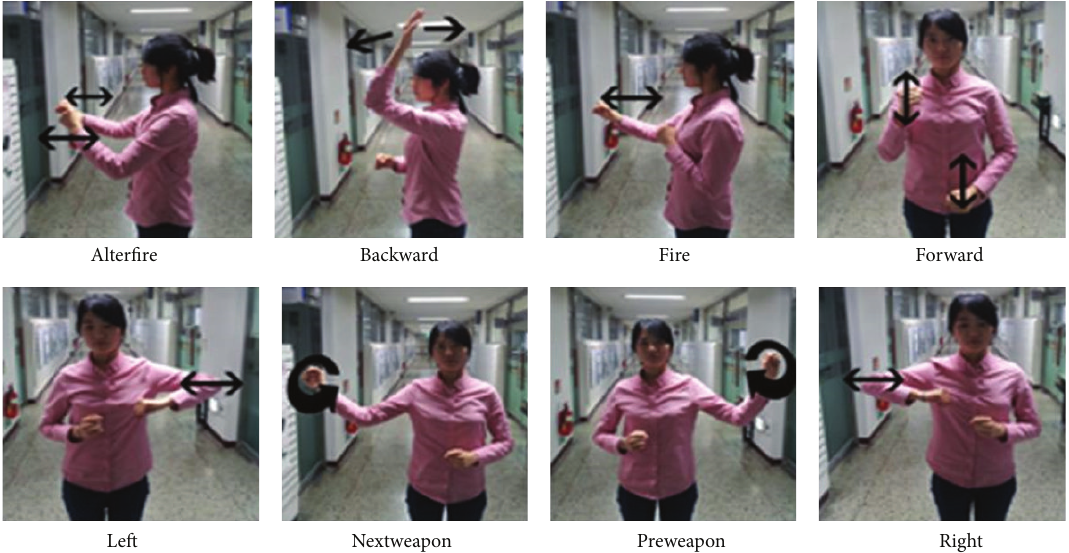
Figure 8: Gestures in Kyonggi dataset.